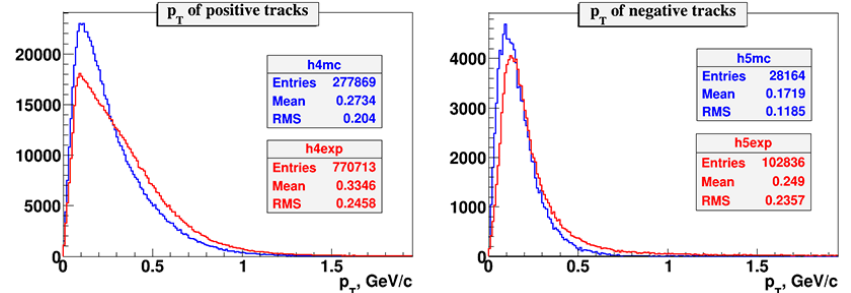
Figure 8. Particle transverse momentum distributions for data and simulation: (left) for positive tracks, (right) for negative